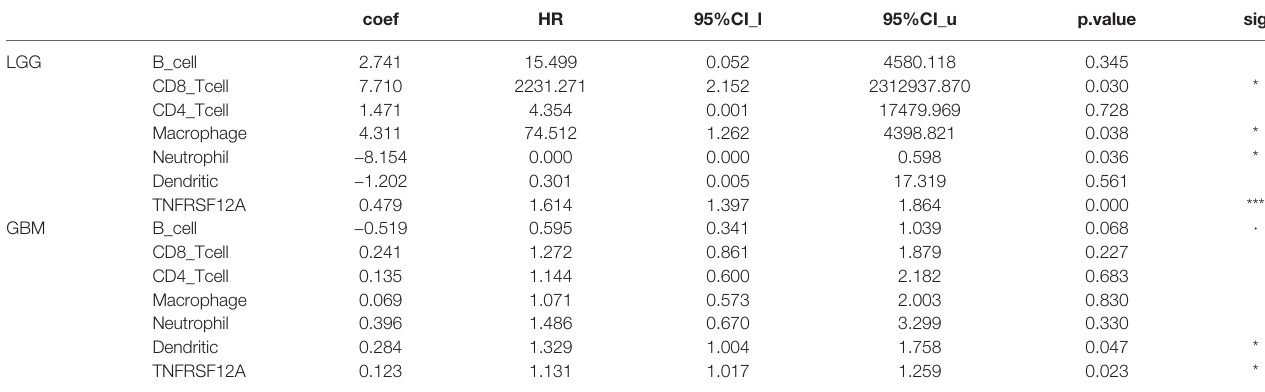
TABLE 3 | Cox proportional risk model of TNFRSF12A expression and in fi ltration of six immune cells in LGG and GBM.